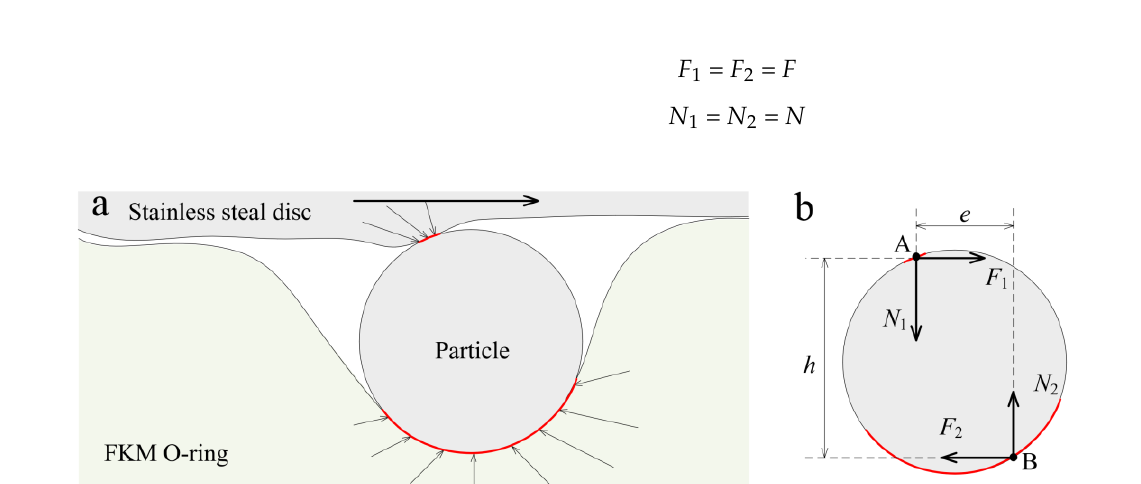
Figure 8. Schematic diagram of ( a ) forces on the particles in the three-body contact of the sealing interface, and ( b ) the sum of forces on an abrasive particle.